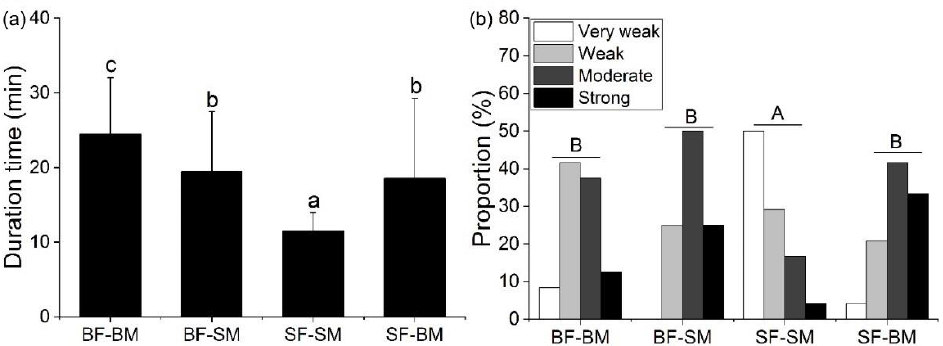
Figure 3. Fighting duration time staged between groups ( a ). The percentage of intensity of fights between groups ( b ). Note: Different lowercase letters represent significant differences between groups ( p < 0.05); capital letters represent significant differences of intensity between groups ( p < 0.05).